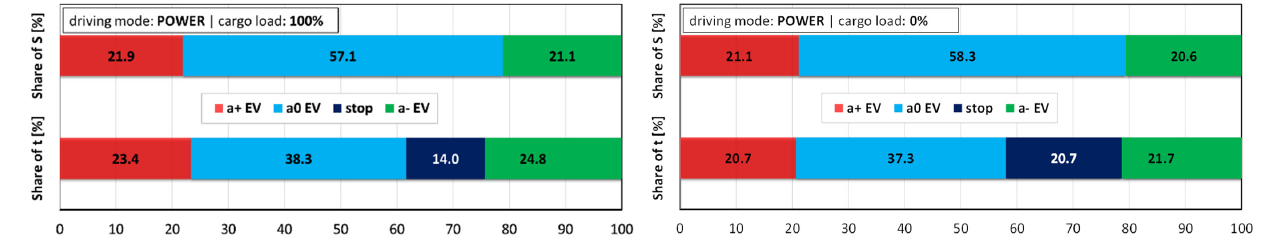
Figure 17. Comparison of the phase motion share during the RDC test regarding the variable cargo load.